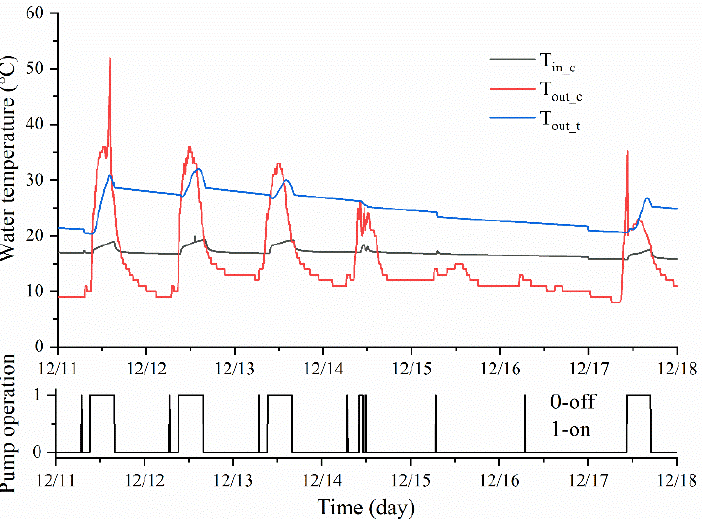
Figure 17. Experimental data of water temperature and pump operation time from 11 December to